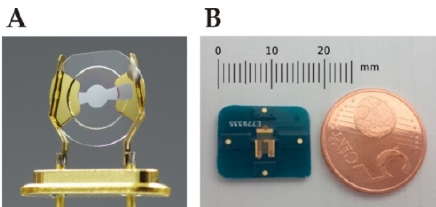
Figure 1. ( A ) Image of 195 MHz HFF-QCM from KVG Quartz Crystal Technology GmbH, (Neckarbischofsheim, Germany). The quartz crystal has diameter of approximately 5 mm, adapted from [93]. ( B ) A 150 MHz HFF-QCM manufactured by Advanced Wave Sensors (AWS) S. L. (Paterna,